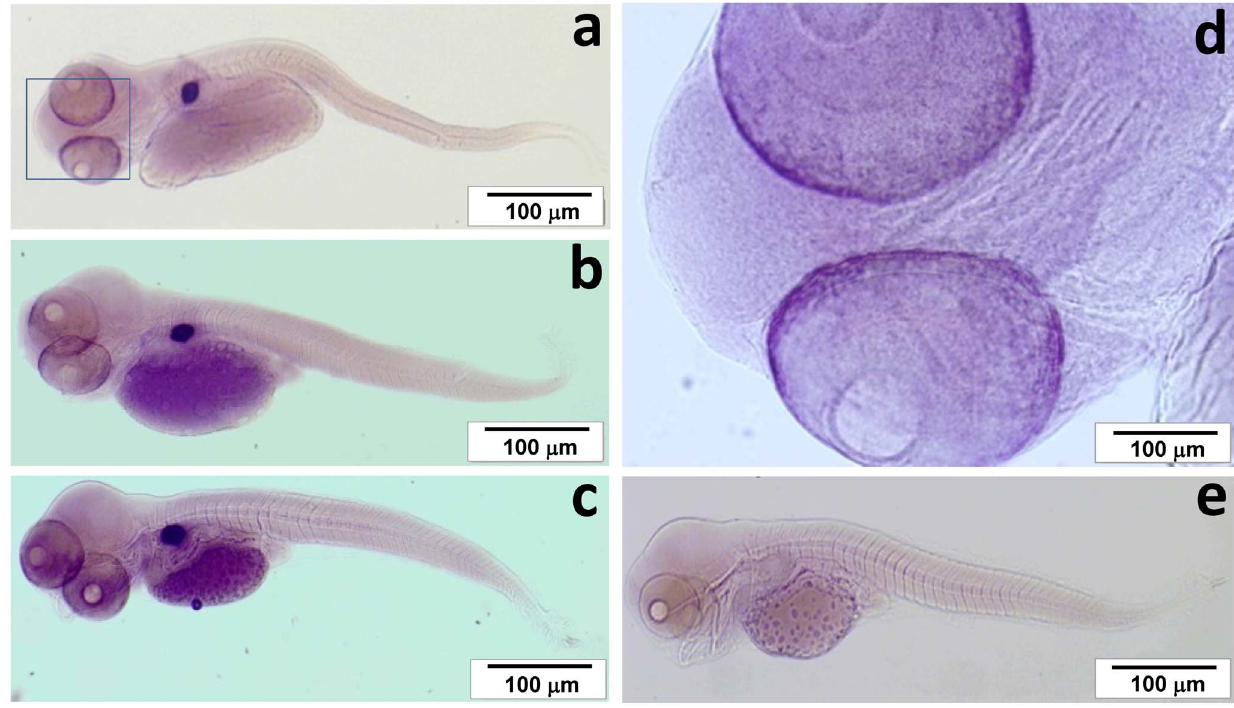
Figure 6. Expression of defb in bladder (a), hindgut (b) and first feeding (c) cod larval stages. Defb is highly expressed in the swim bladder and in the eye. The eye is magnified showing a strong positive signal on the edges of the retina (d). No positive signal is seen in negative controls with the sense probe (e).